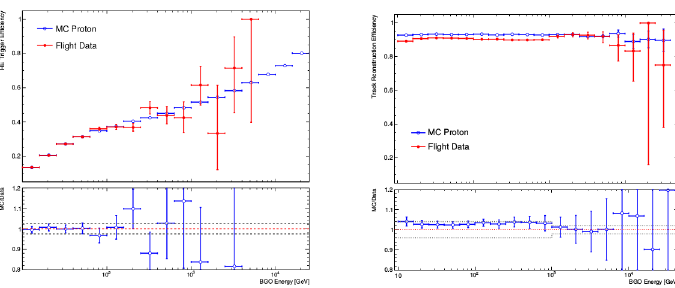
Figure 1. Left - The HET e ffi ciency as a function of BGO energy. Right - The Track reconstruction e ffi ciency as a function of BGO energy. In both plots the red points are for flight data and the blue points are for MC data.